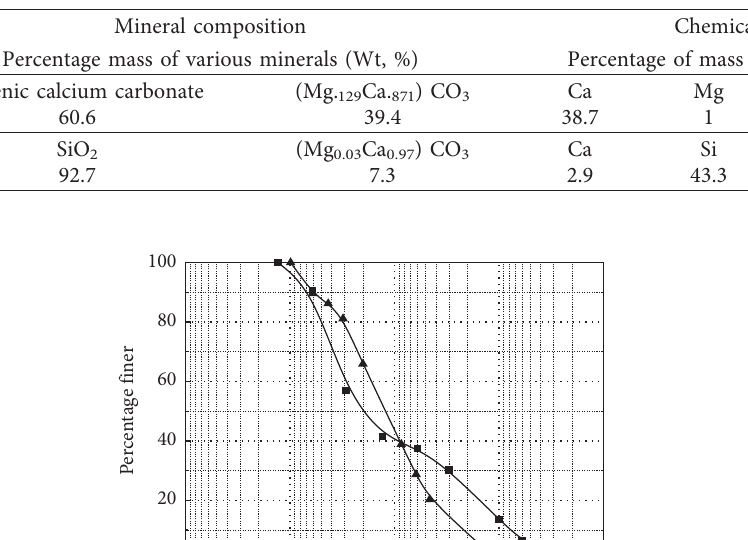
Table 1: Mineral composition of coral mud and Taizhou